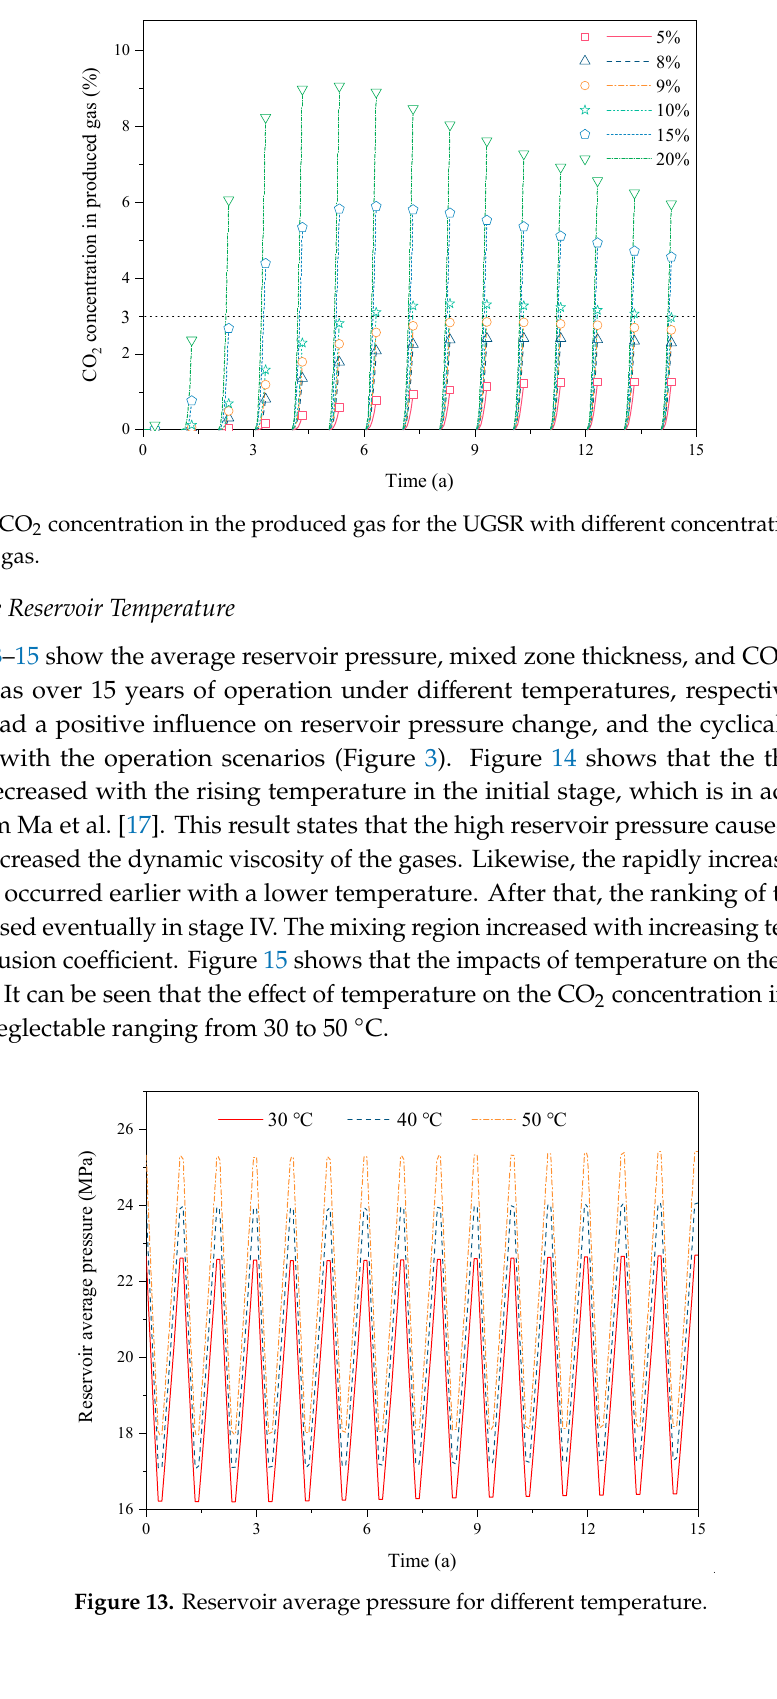
Figure 14. Thickness of the mixed zone for different temperature.